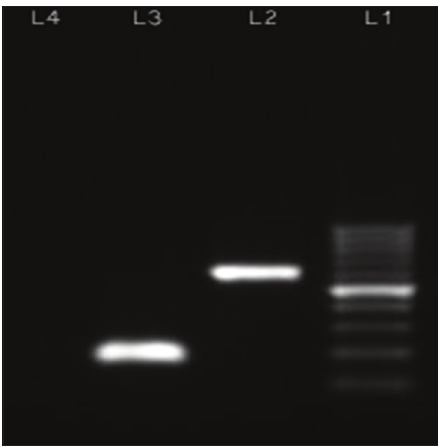
Figure-4: Photograph shows Lane 1 - 100 bp ladder; Lane 2 - 602 pb primary polymerase chain reaction amplicon;